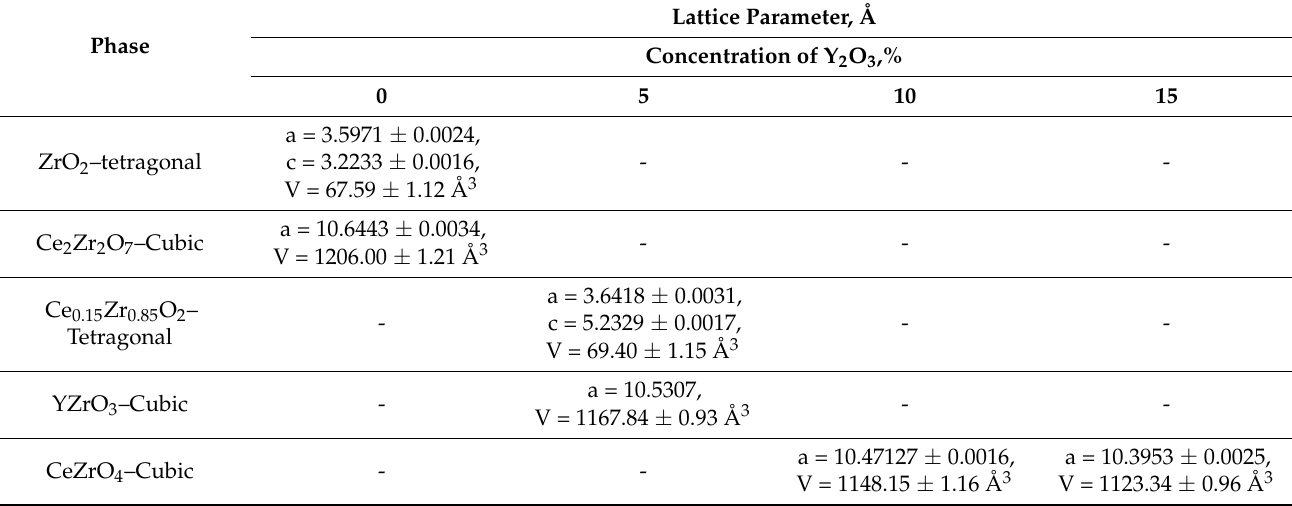
Table 1. Lattice parameter